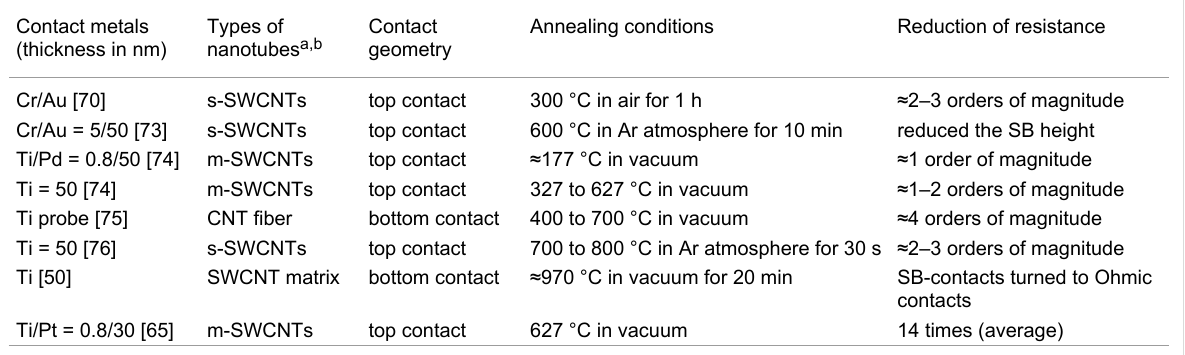
Table 2: Different annealing conditions for commonly used contact metals in CNFETs. Contact metals (thickness in nm)